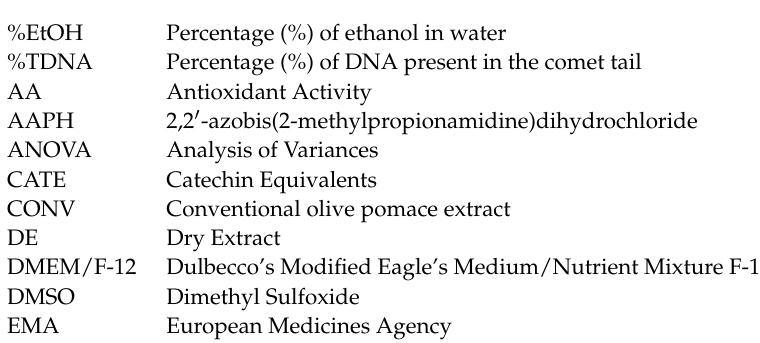
Supplementary Materials: The following are available online. Figure S1: Stability studies from 1 to 6 months of OL standard, HT standard, OL and HT in CONV, and HT in OPT3 at 4 different conditions of T and RH, Figure S2: Full scan mass spectra acquired in ESI- from peaks at retention time 15.91 min and 18.83 min detected in the analysis of OL aqueous standard solution after exposure for 2 days at 40 ± 2 ◦ C and 75 ± 5% RH, and scan chromatogram, Figure S3: UV Chromatogram at 280 nm, scan chromatogram in ESI − and full scan mass spectra from peak at retention time 10.14 min detected in the analysis of HT aqueous solution after 30 days exposure at 40 ± 2 ◦ C and 75 ± 5% RH, Table S1: ANOVA of all responses measured for extracts generated by conventional phenolic extraction conditions, using OP stored at different conditions, Table S2: ANOVA of the effect of 2 different defatting methods on the responses measured for extracts generated by conventional phenolic extraction conditions, using freeze-dried OP, Table S3: ANOVA of the effect of the extract drying on the stability of the responses measured compared to a freshly obtained liquid extract (reference), Table S4: ANOVA of the genotoxic effect (alkaline comet assay) of OP extracts (0.8 mg/mL CONV and 0.4 mg/mL OPT3), together with 300 µ M (162.2 mg/L) OL, 100 µ M (15.4 mg/L) HT and their mixture (5 µ M/2.7 mg/L + 50 µ M/7.7 mg/L OL+HT) on HCE and IM-ConjEpi cells treated for 24 h, compared to control cells (treated with culture